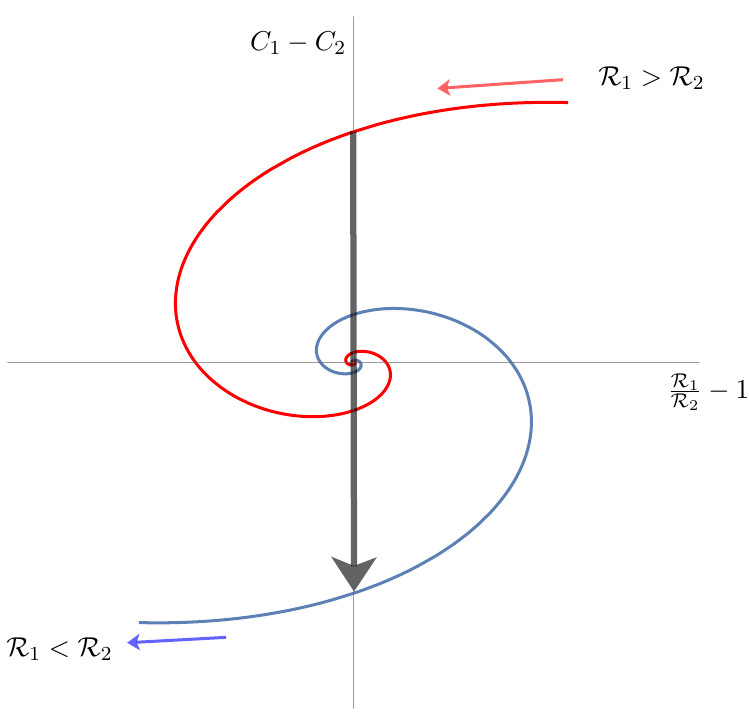
Figure 2 . The two spirals correspond to the solutions in which sphere 1 shrinks to zero in the IR (red) and to those in which sphere 2 shrinks (blue). As we cross the vertical axis, the dominant solution jumps from the red to the blue